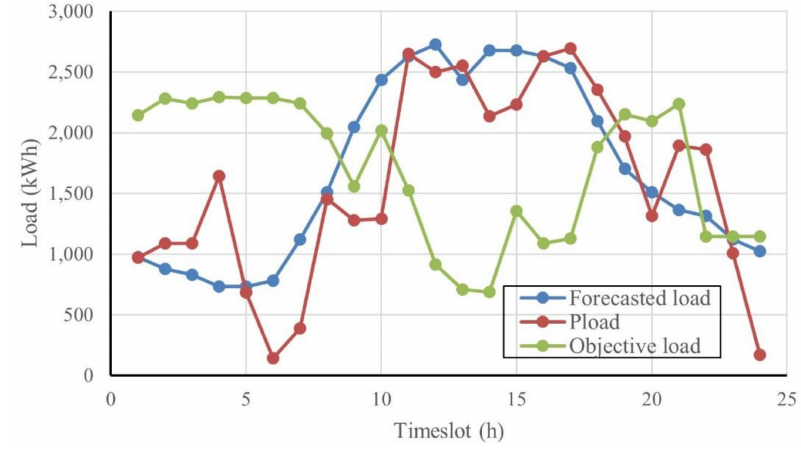
Figure 10. Hourly industrial load before and after shifting using TOU-SBY.